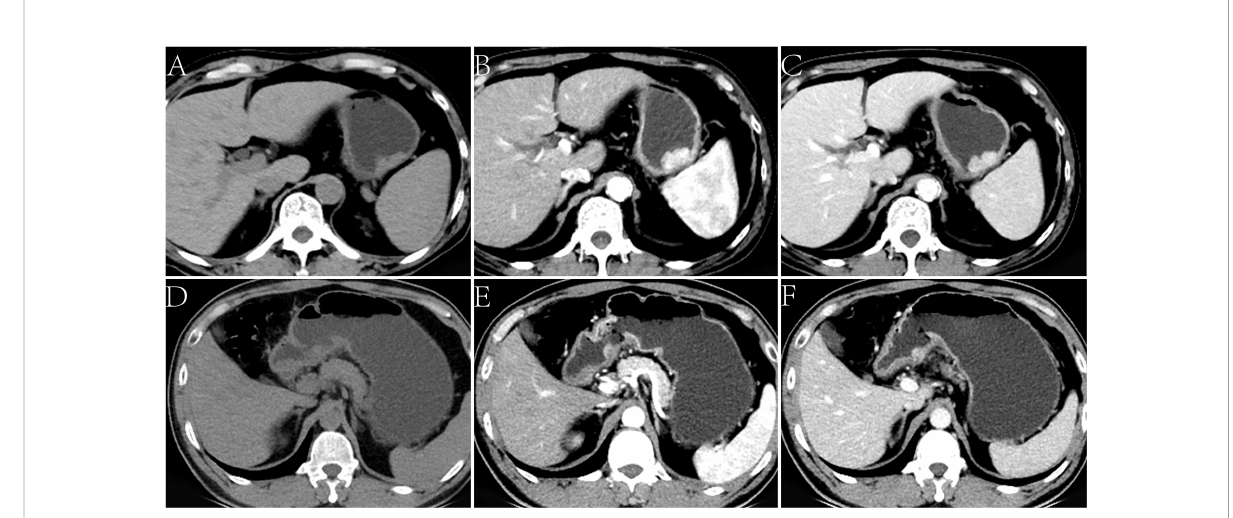
FIGURE 2 Lymphoepithelioma-like gastric carcinoma (LELGC) in a 60-year-old man (A-C) and non-LELGC in a 51-year-old woman (D-F) . Unenhanced CT image of stomach reveals a mass in the gastric body (A) . Contrast-enhanced CT image shows a continuously obvious homogeneous enhancement of mass (B, C) with CT venous of 110.20 HU. Unenhanced CT image of stomach reveals a mass in the gastric antrum (D) . Contrast- enhanced CT image shows a gradually moderate nonhomogeneous enhancement of mass (E, F) with a CT venous of 67.16 HU.